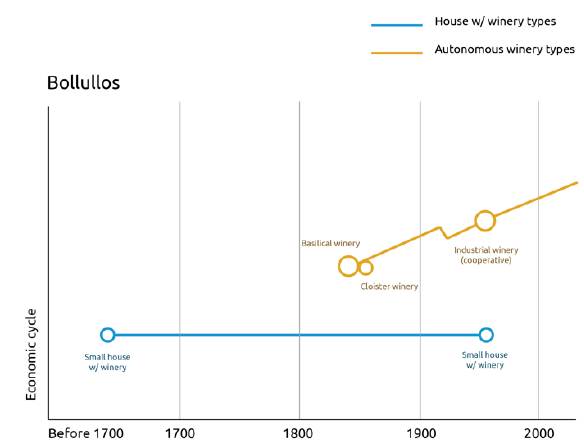
Figure 13. Chronological display of Bollullos’ winery types, by typological line of